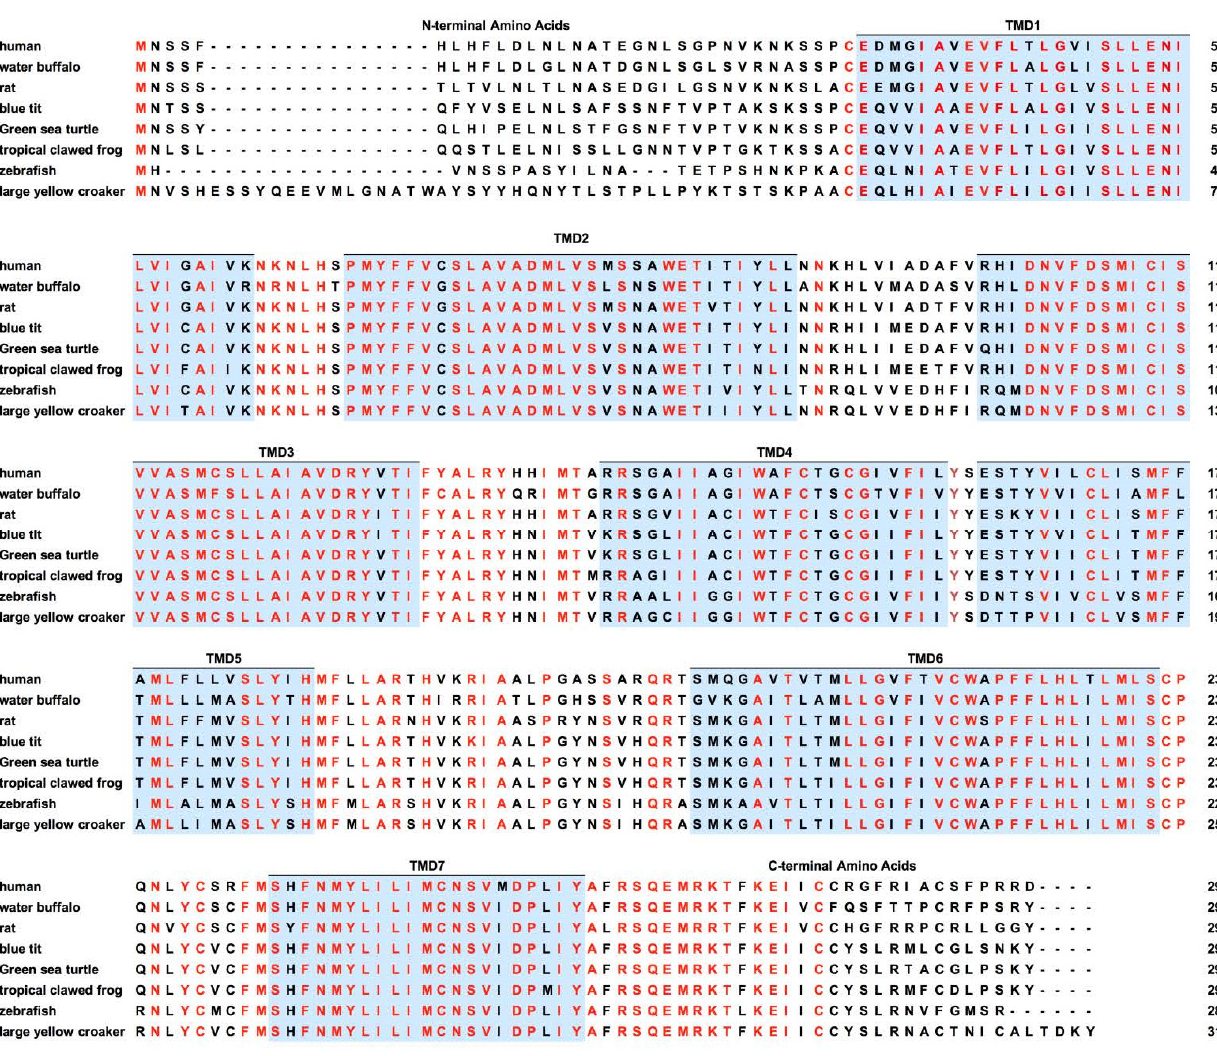
Figure 3. Sequence alignment of multiple MC5Rs. The transmembrane (TM) regions are represented by blue shadow and are numbered 1–7. The 100% identical residues are indicated in red. MC5Rs: Homo sapiens (human, NP_005904.1), Mus musculus (mouse, NP_038624.3), Bubalus bubalis (water buffalo, XP_025129279.1), Cyanistes caeruleus (blue tit, XP_023777141.1), Chelonia mydas (green sea turtle, XP_007063924.1), Xenopus tropicalis (tropical clawed frog, NP_001096392.1), Danio rerio (zebrafish, NP_775386.1), and Larimichthys crocea (large yellow croaker, XP_010746135.1).